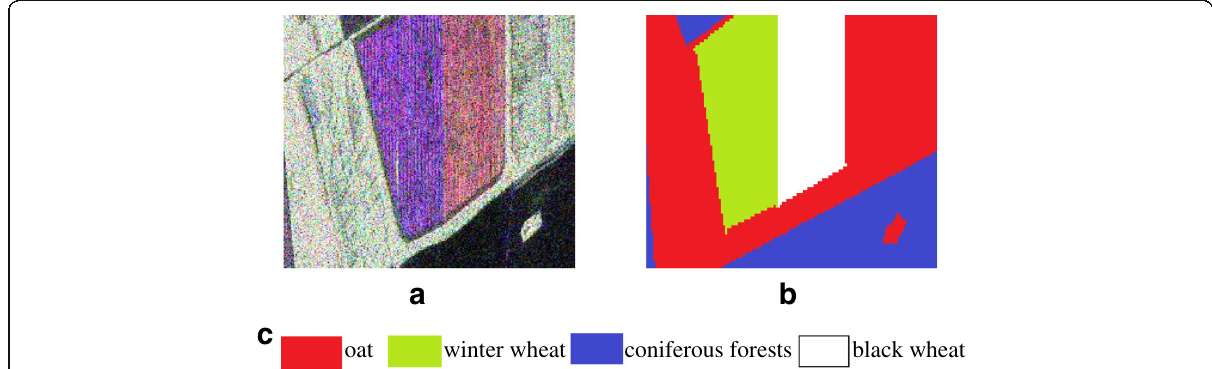
Fig. 4 The PolSAR image and truths plots in Foulum. a The color image of the Pauli decomposition of RGB. b The ground reference map. c The image of colored objects